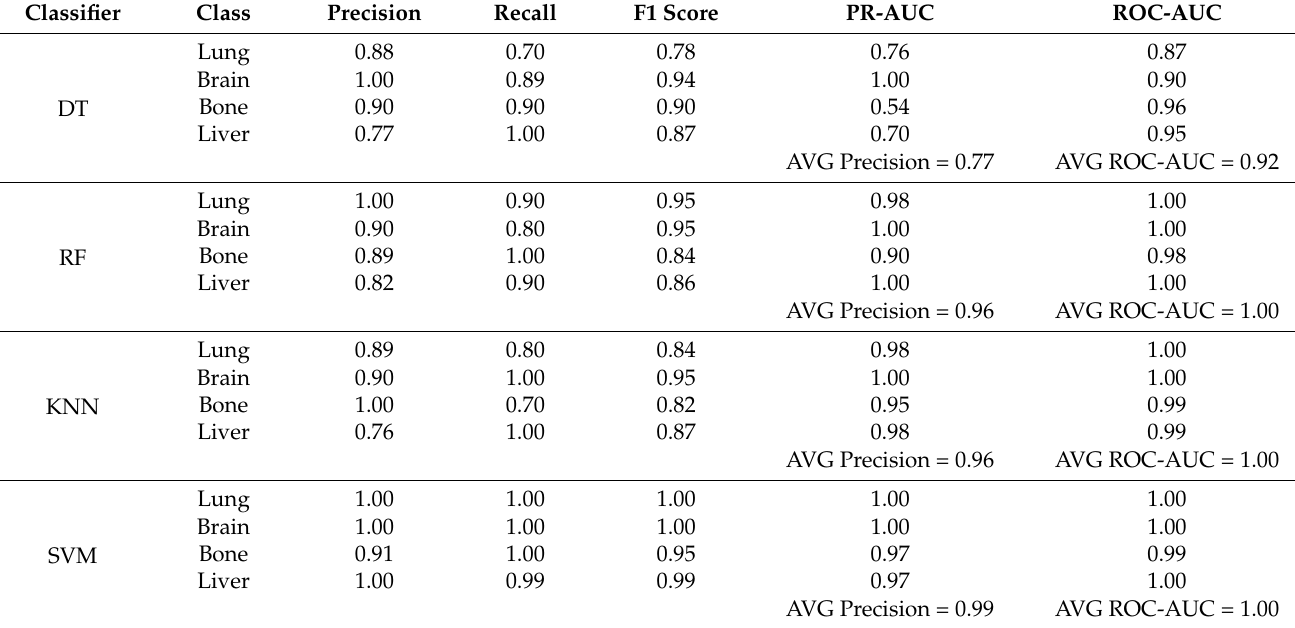
Table 3. Evaluation Metrics for Comparative Analysis of Proposed